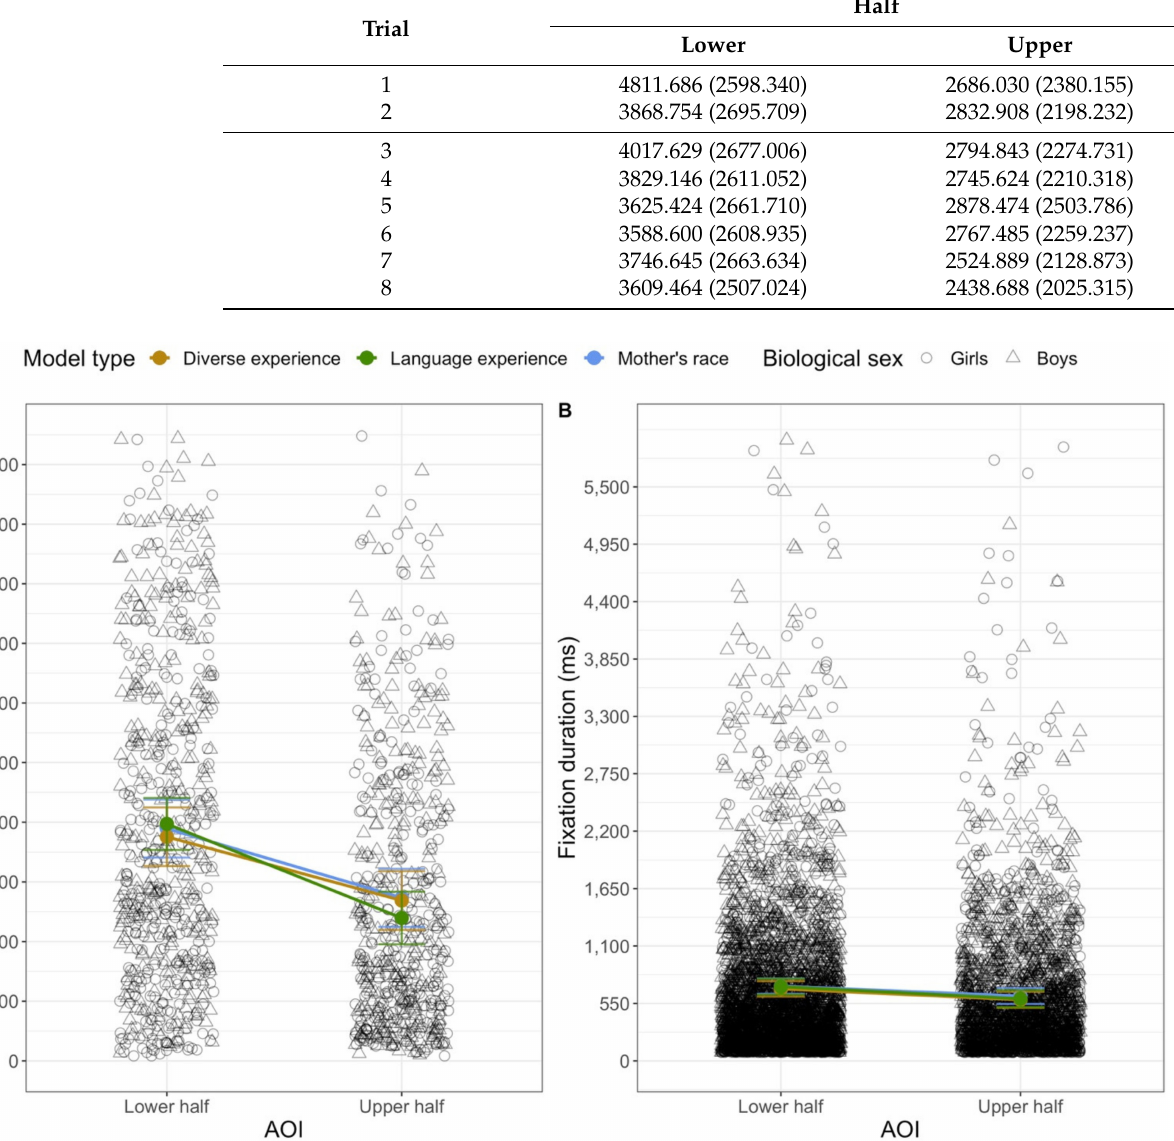
Figure 4. Duration of ( A ) looking summed across fixations within a trial and ( B ) for each individual fixation on each trial to the upper and lower halves, averaged across infants and trial types. Each open circle is the duration on a single trial from a single infant ( A ) or a single fixation on a single trial from a single infant ( B ). The lines represent the estimated marginal means for each of the three models, and the error bars represent 95% Sidak-adjusted confidence intervals calculated from the models. Note, for clarity, the graph for the fixation durations does not include three fixations that were between 6000 and 8000 ms, but those fixations were included in the model. The biological sex of each infant is indicated by the shape of the